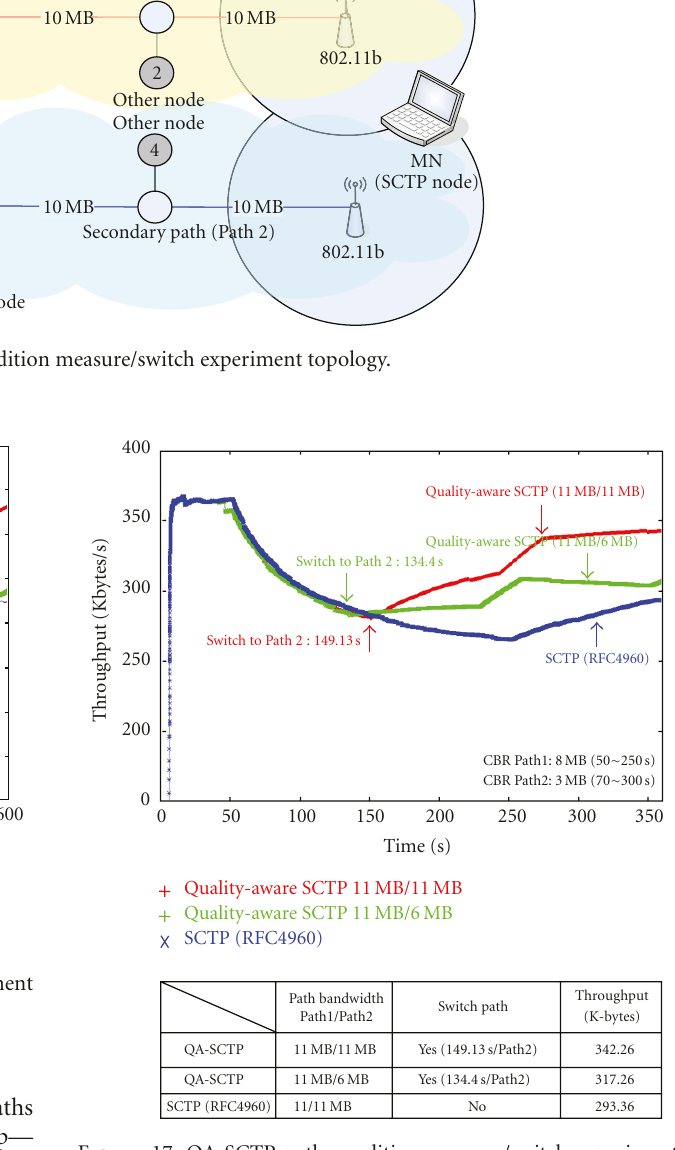
Figure 17: QA-SCTP path condition measure/switch experiment